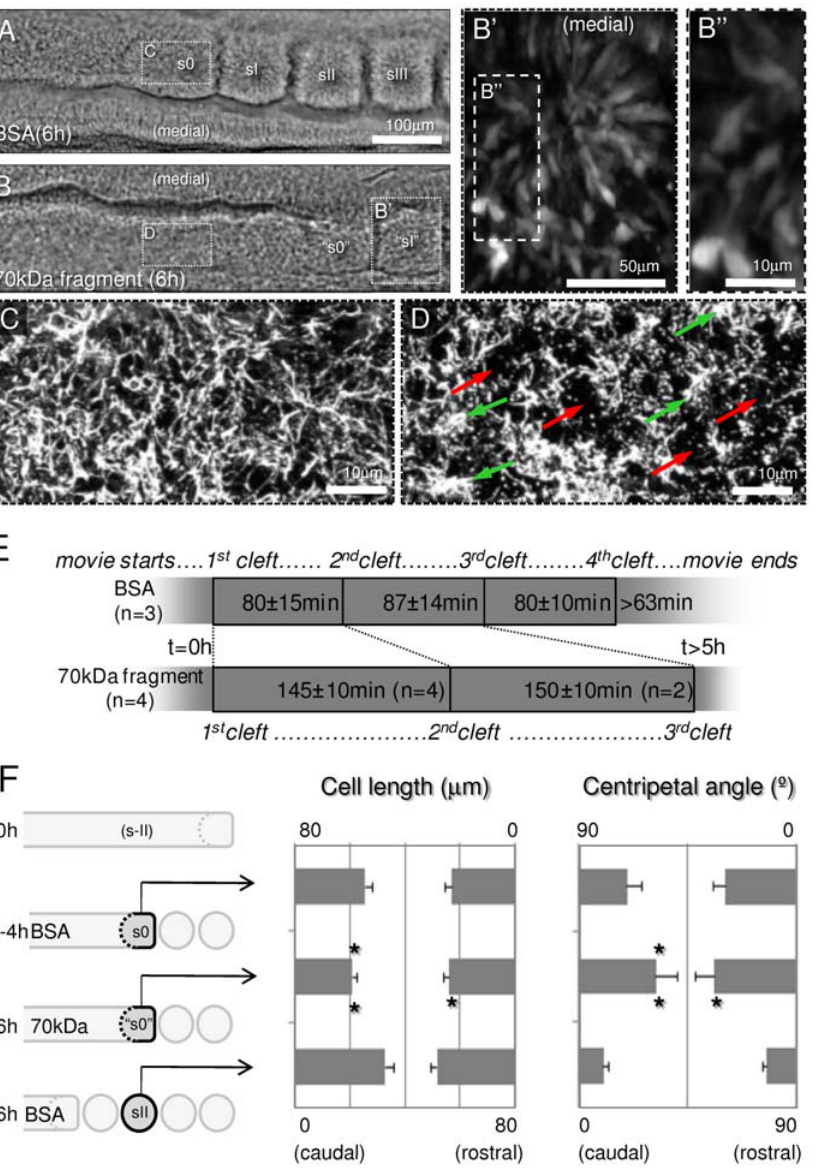
Figure 3. Inhibiting FN matrix assembly impairs somite formation by affecting cell elongation and alignment. A and B ) Bright-field images showing equivalent halves of embryos cultured for 6 hours either under control (BSA) conditions (A) or with the 70 kDa FN fragment (B). The control embryo formed three complete somites (sI-sIII) and an advanced s0 (A), while the 70 kDa fragment-treated embryo formed only one somite (marked ‘‘sI’’) and an incipient ‘‘s0’’ (B). B 9 is a two-photon section showing an ‘‘sI’’ of a GFP-electroporated and 70 kDa fragment-treated embryo showing impaired cell elongation and alignment (see also Video S4), particularly in the caudal side (B 0 ; compare with Figure 2A + 6h). C and D ) FN matrix covering the dorsal surface of the PSM at equivalent axial positions of control explants (s0, C) and explants treated with the 70kDa fragment (‘‘s-II’’, D). Ectoderm-associated FN was digitally removed to show only the PSM FN matrix. Explants treated with the 70 kDa fragment (D) show numerous large holes in the FN matrix (red arrows) interspersed with dense agglomerates of FN (green arrows), contrasting with the more uniform fibrillar matrix of control explants (C). E ) Timing of intersomitic cleft formation as determined from analysis of bright-field time-lapse image sequences. Control embryos (n=3) formed three new somites in approximately 4 hours, while experimental embryos (n=4) took almost 5 hours to form either one (n=2) or two (n=2) new somites. F ) Graphical representation of cell lengths and centripetal angles of rostral (n=10 cells/embryo) versus caudal (n=10 cells/embryo) somitic cells in control embryos at mid-culture (s0, n=3), experimental embryos at 6 hours (‘‘s0’’, n=3) and control embryos at 6 hours (sII, n=3). Comparing cells in ‘‘s0’’ with the equivalent cells of control embryos, which had matured to sII stage, showed that caudal cells were significantly less elongated and aligned ( P , 0.001) in the ‘‘s0’’, and so were rostral cells ( P =0.004 and P , 0.001, respectively). Comparing cells in ‘‘s0’’ to cells of control s0 revealed significant differences in caudal cell elongation ( P , 0.001) and alignment ( P =0.007) whereas no differences in those parameters were detected rostrally ( P =0.643 and P =0.368, respectively). Error bars represent 95% confidence intervals. Asterisks represent significant differences of ‘‘s0’’ when compared to sII (bottom asterisk) or s0 (upper asterisk).